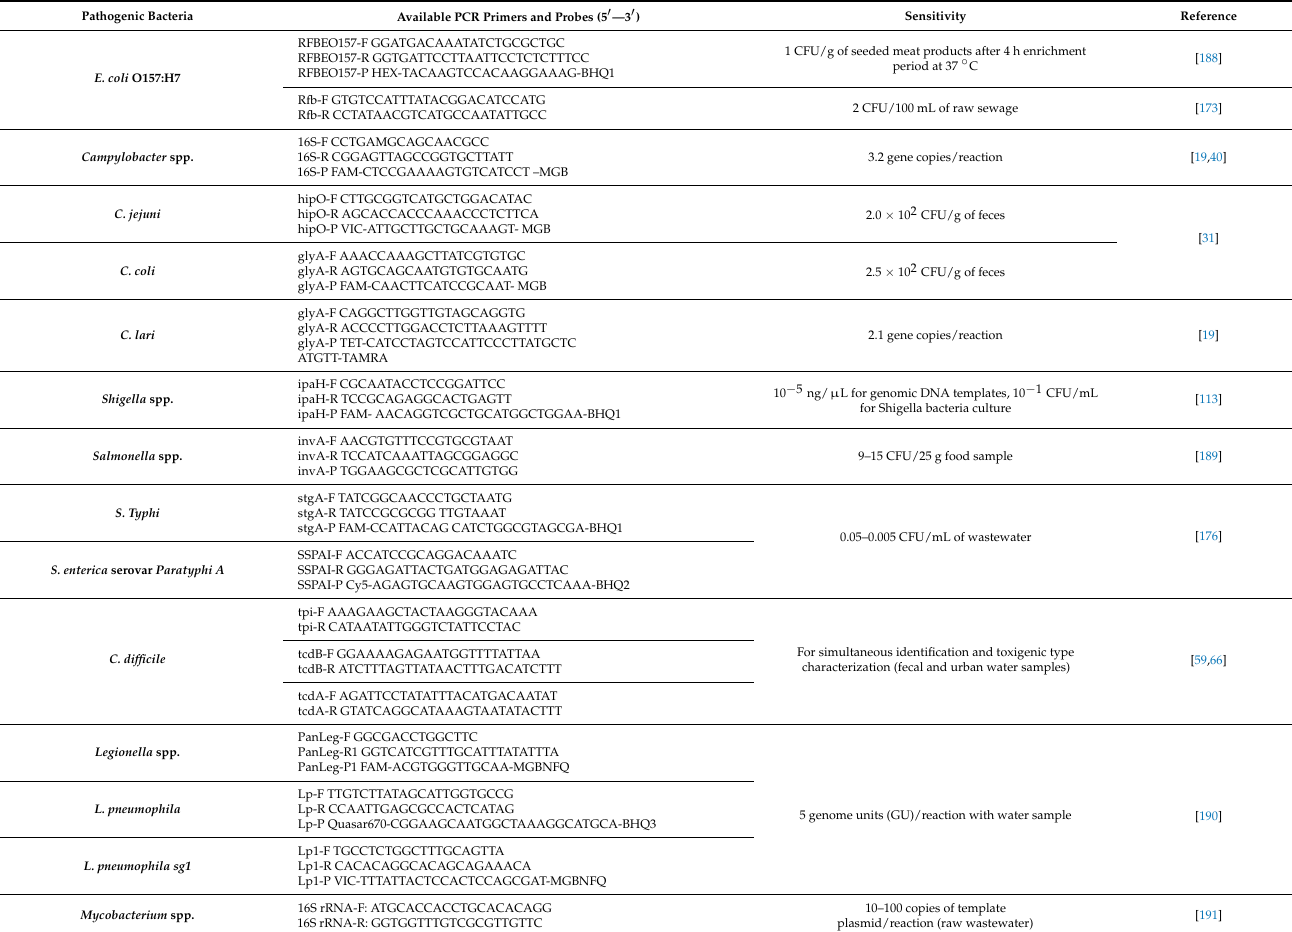
Table 5. PCR primer-probe sets available for the detection and quantification of typical pathogenic bacteria in wastewater and other